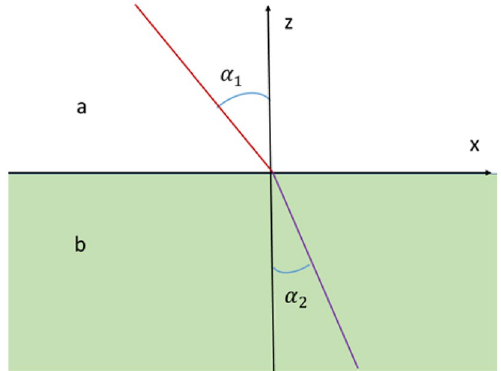
Figure 3. Refraction of light between two